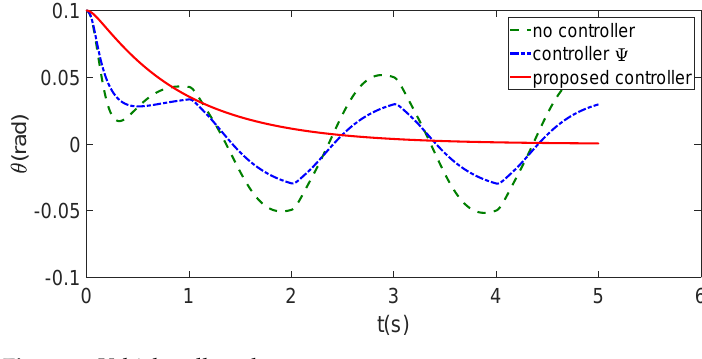
Figure 5. Vehicle roll angle.